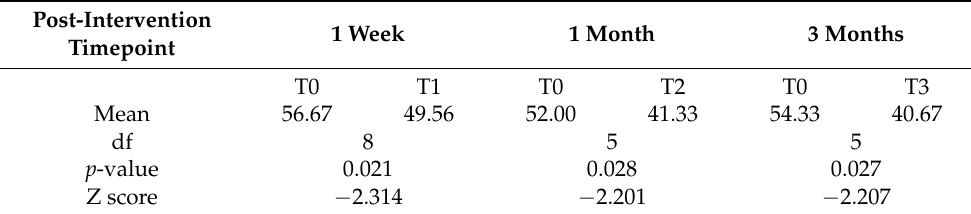
Table 1. Wilcoxon test results. All three comparisons reject the null hypothesis, indicating statistically significant decrease at postintervention from baseline preintervention DERS-18 score.